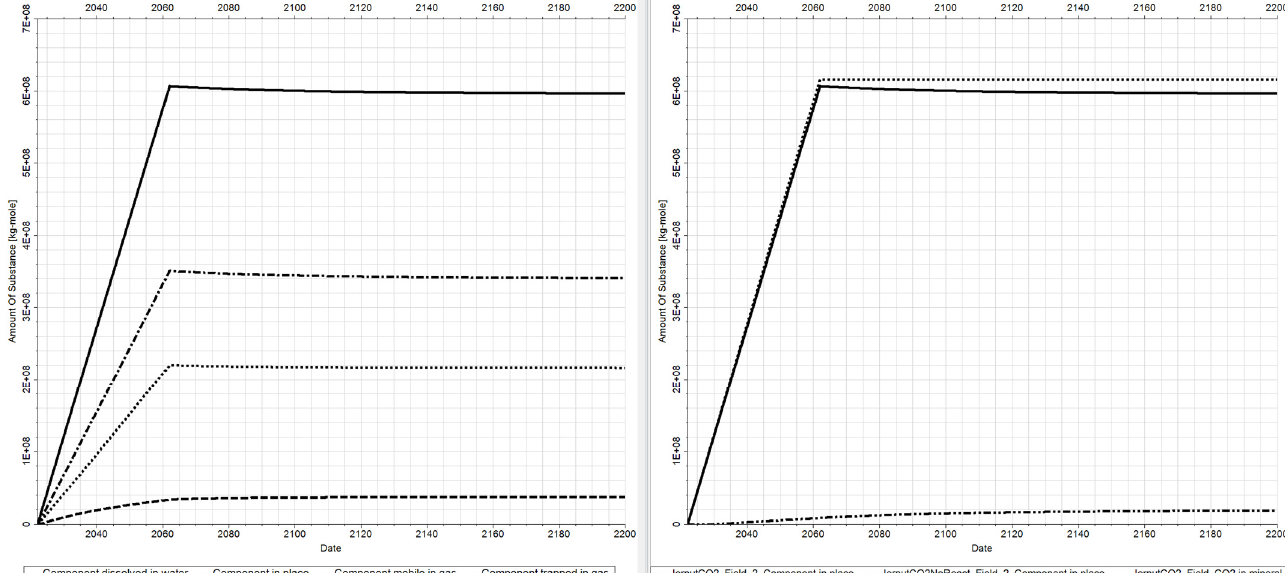
Figure 8. CO 2 trapped in the reservoir—total and by individual mechanisms ( left ); in mineral ( right ).